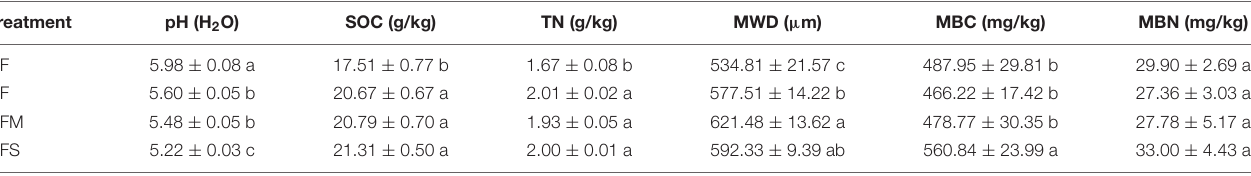
TABLE 1 | Basic properties of bulk soil samples under different